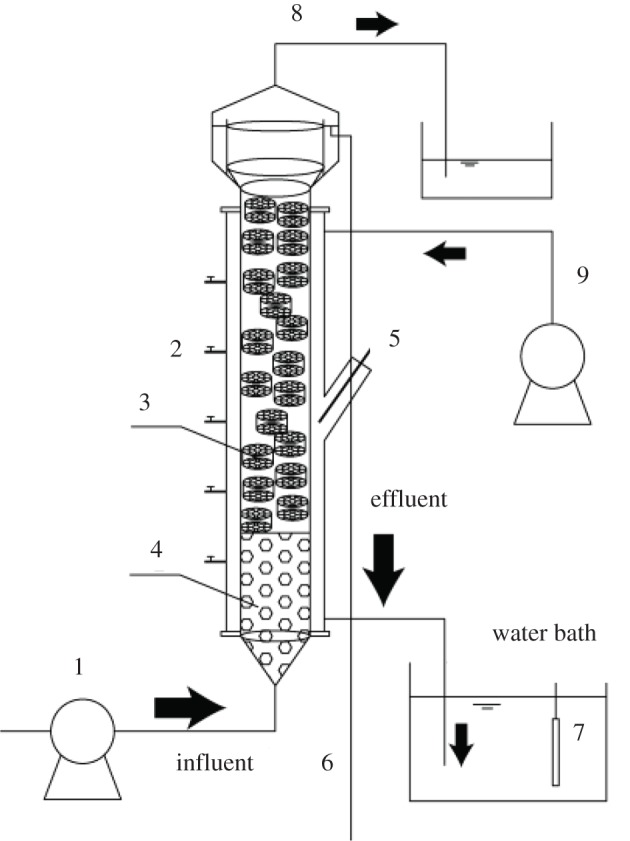
Schematic diagram of UASB reactor. 1, Influent pump; 2, sampling port; 3, Kaldnes ring; 4, granular sludge; 5, thermometer; 6, effluent; 7, heating rod; 8, outlet port; 9, water bath pump.